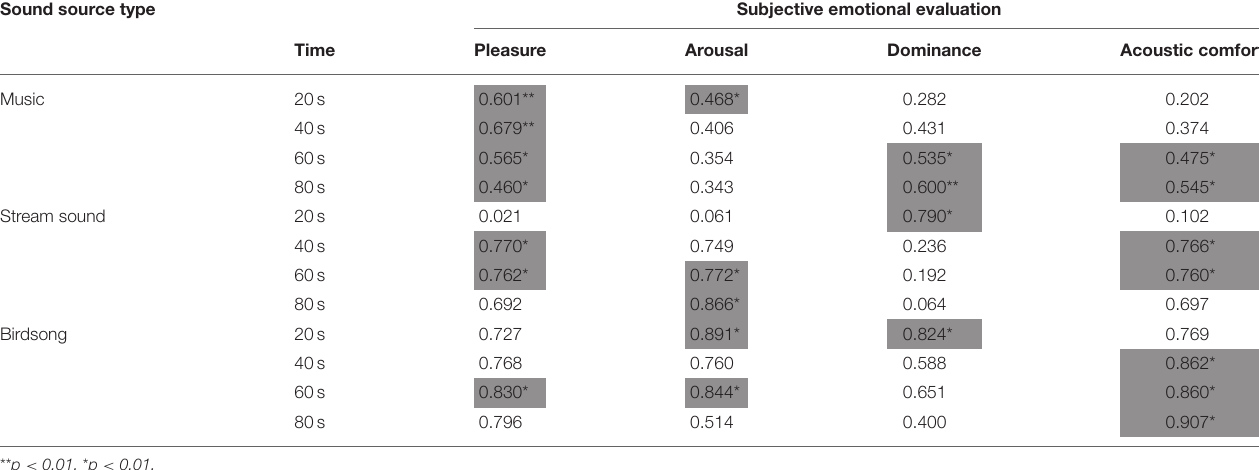
TABLE 5 | The relationship between subjective emotional evaluation and facial expression valence in three sound interventions at 20, 40, 60, and 80.